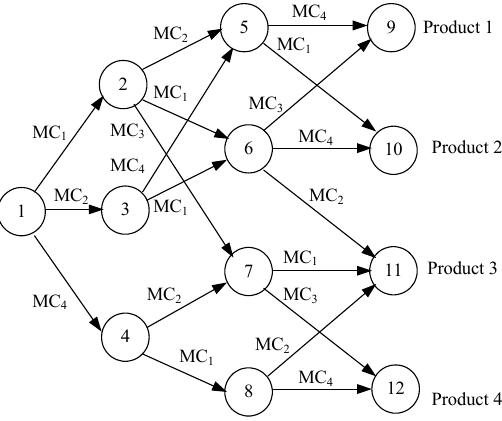
Figure 5. Four product production system.